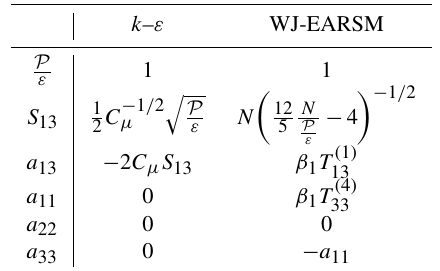
Table 4. Analytical values in the log layer of the half-channel